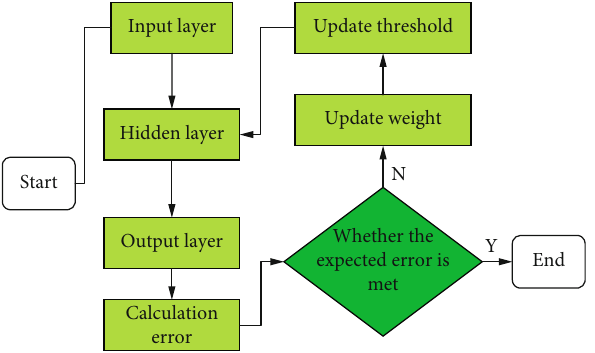
Figure 1: BP neural network algorithm fl